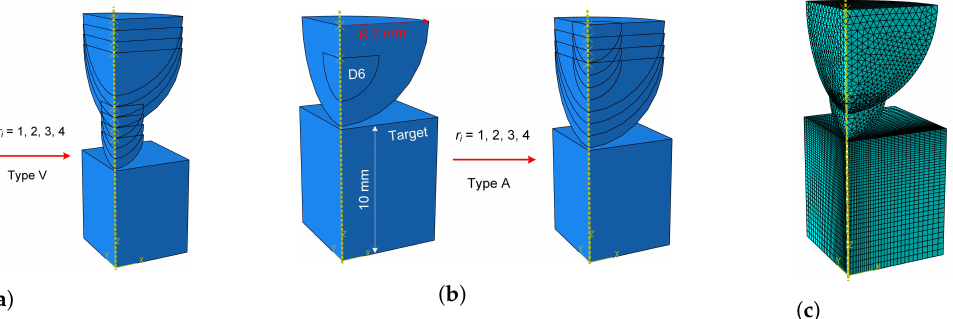
Figure 3. ( a ) Type V, ( b ) Type A finite element model of combined hammer peening and ( c ) D6-D14 mesh size.